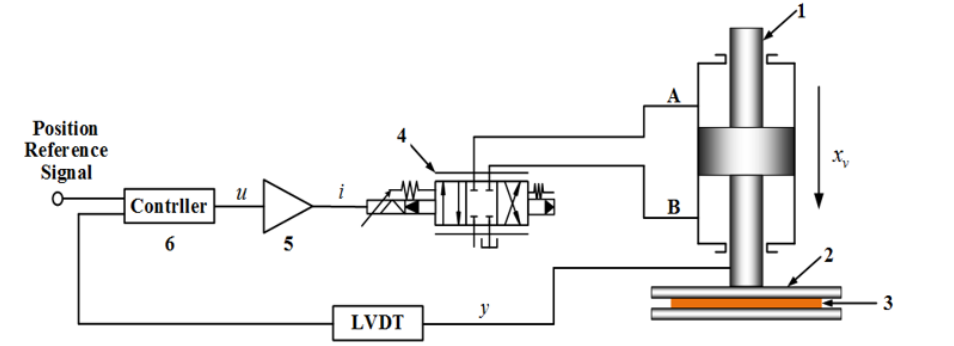
Figure 1. Schematic diagram of MDF plate thickness correction position servo system.